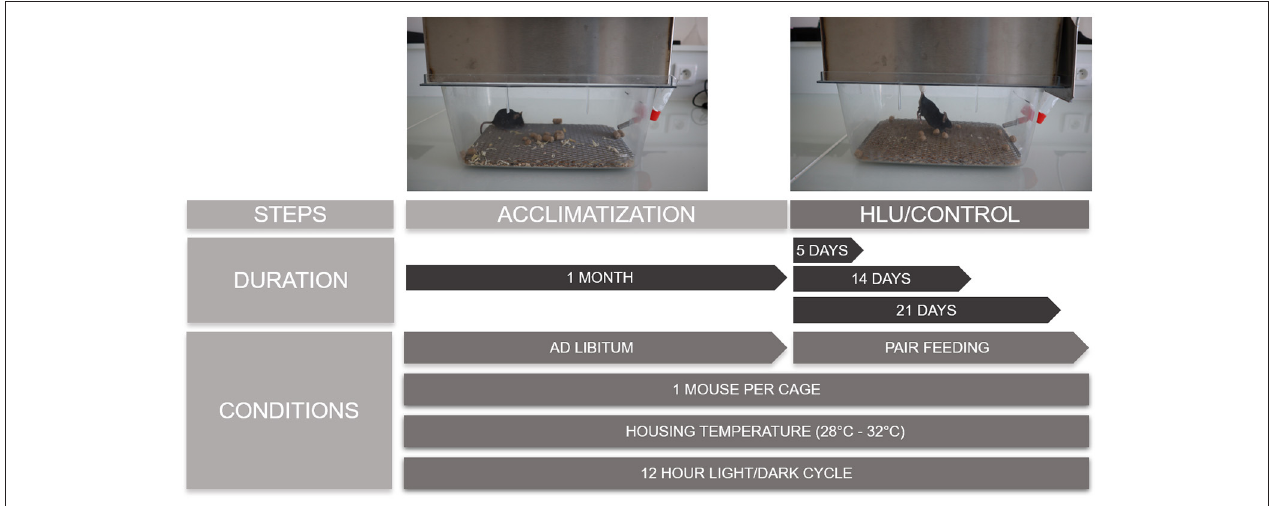
FIGURE 3 | The scheme is reporting pictures of a C57BL/6J mouse during the acclimatization and suspension periods and the conditions and duration of each phase. Sufficiently long periods of acclimatization with ad libitum food and water have to be guaranteed, followed by the required periods of suspension where the control mice are pair fed with the suspended ones. Mice are singly housed without straw at thermoneutral temperatures of 28–32 ◦ C with 12-h light and dark